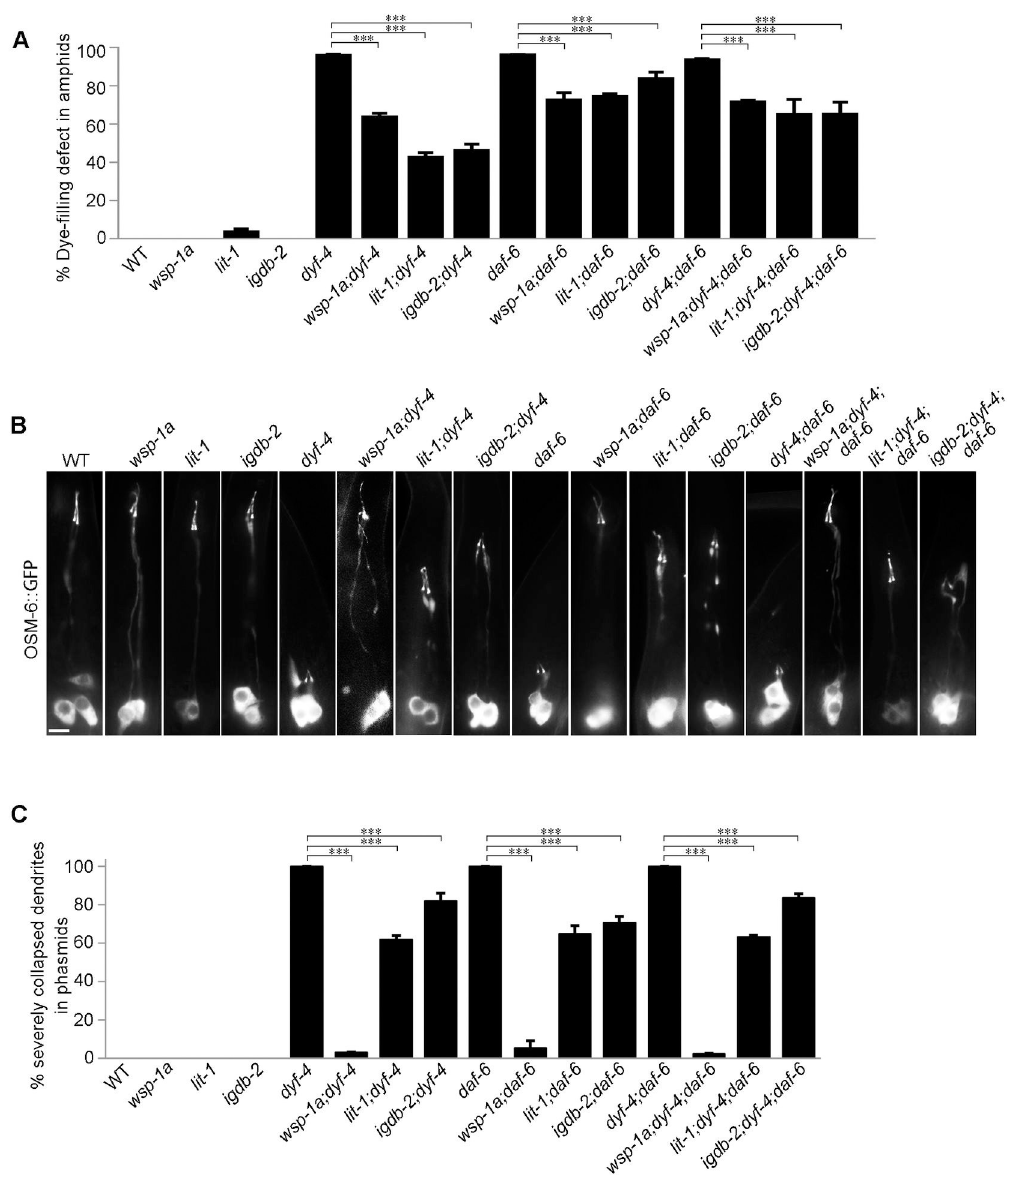
Fig 6. Suppressors of daf-6 inhibit defects in dendrite extension in both dyf-4 and daf-6 mutants. (A) Statistics of the dye- filling defect percentages in the amphid neurons of the indicated worm lines. Suppressors of daf-6 , wsp-1a (gm324) , lit-1 (or131) and igdb-2 inhibited the defects in dendrite elongation in dyf-4 and daf-6 mutants. (B) Fluorescence micrographs of phasmid dendrites in the indicated genetic background. Scale bar: 5 μ m. (C) The percentages of severely collapsed dendrites of the phasmid in the indicated worm lines. Dendrites with cilia located near the cell bodies are defined as severely collapsed dendrites. Data are presented as the mean ± SEM from three independent experiments (n � 80 per experiment). ��� P � 0.001 (Fisher’s Exact